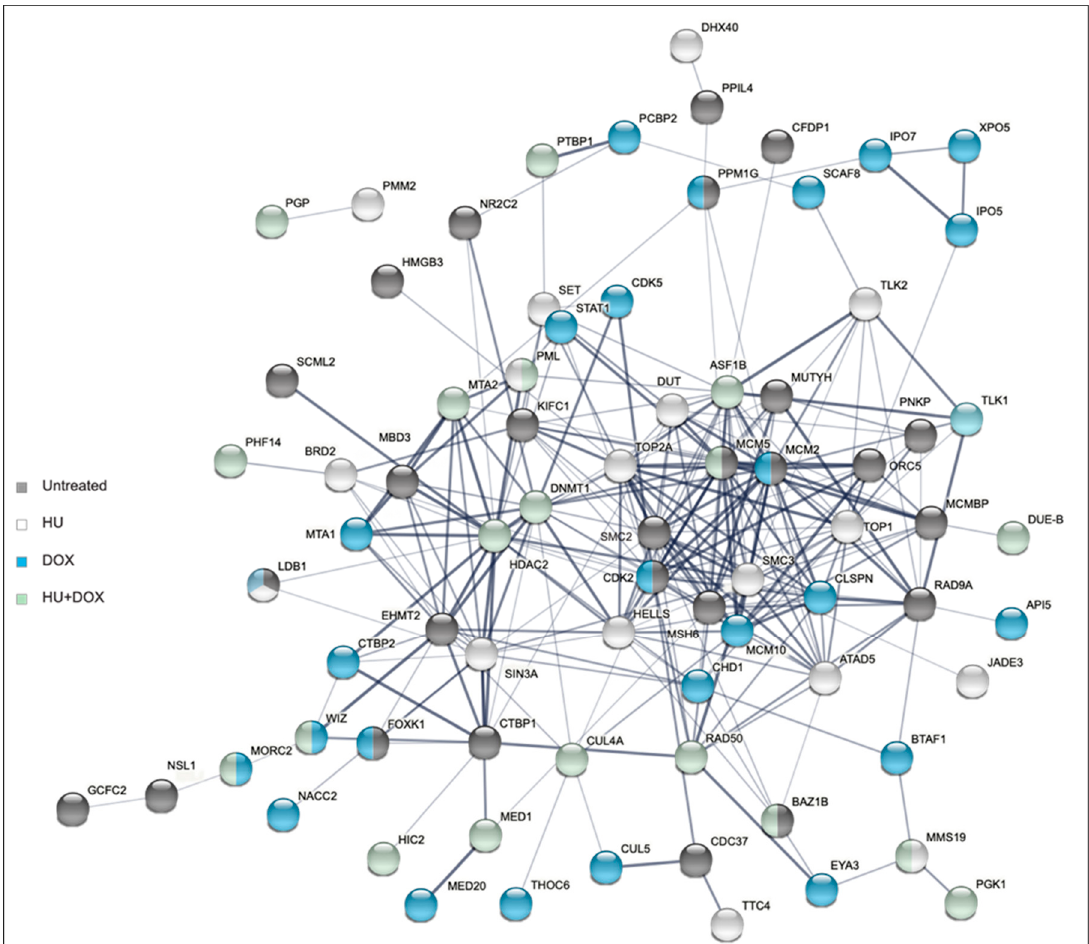
Figure 7. Network analysis for all positive hit loci with >2-fold shRNA enrichment whose proteins are enriched at sites of nascent DNA. Nodes are color coded by treatment. Edge thickness indicates the relative confidence in an interaction. Virtually 100% of the positive hit loci were part of an interconnected network but enriched in only one treatment.